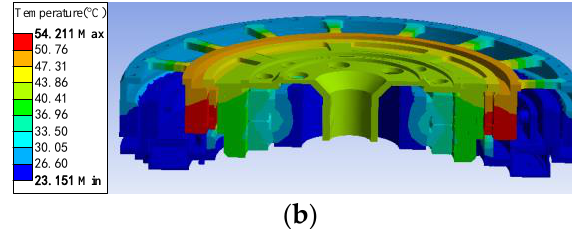
Figure 17. Finite element analysis of the MLRW. ( a ) 3-D finite element mesh of the MLRW. ( b ) The predicted thermal field of the MLRW by FEM.